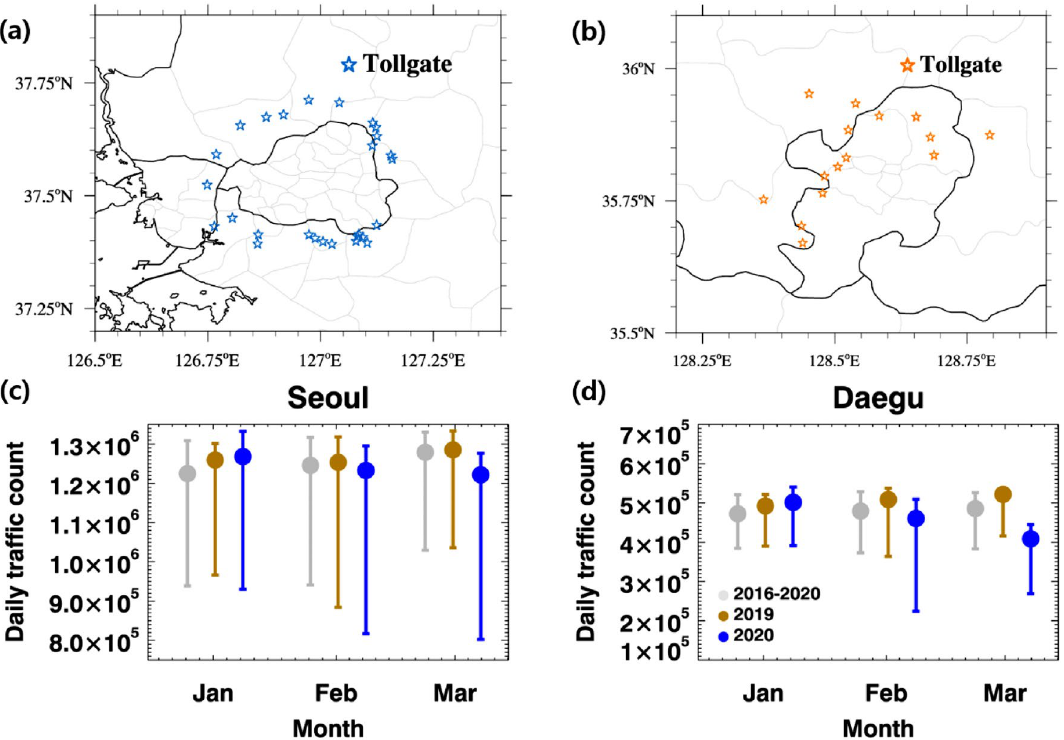
Figure 5. The location of tollgates around ( a ) Seoul and ( b ) Daegu considered in this study. Also, January, February, and March means of the daily traffic count for the entrances and exits of ( c ) Seoul and ( d ) Daegu for 3 periods: 2016–2020, 2019, and 2020. Figure was produced using the NCAR Command Language (NCL) version 6.4.0, which is opened to the public. Download is available at the next website: http://www.ncl.ucar.edu/ Downl oad/. For the map information of these figures, we used the geospatial Data provided from the National Geographic Information Institute in South Korea (NGII, ). Data download is available at the next website: http:// data.nsdi.go.kr/datas et?q=%ED%96%89%EC%A0%95&sort=score +desc%2C+views _total +de479